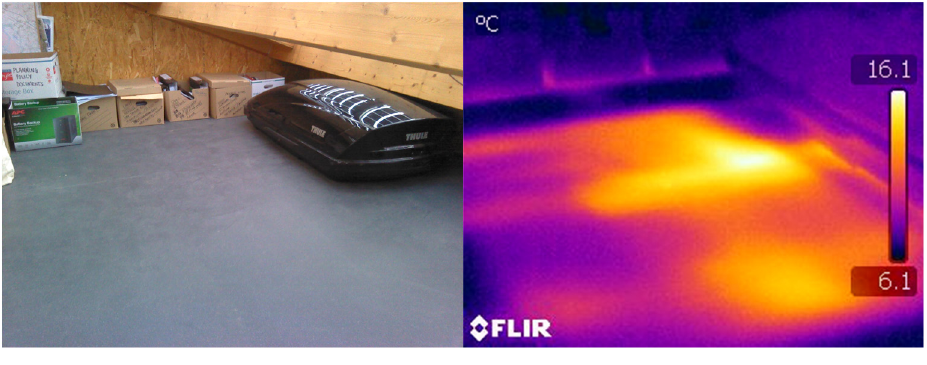
Figure 9. ( a ) The air leakage through the loft hatch during a blower door pressure test. ( b ) Roof space floor (left) and a thermal image of the floor in the roof space (right), indicating increased heat loss shown by relatively warmer areas where the thermal insulation was disturbed.